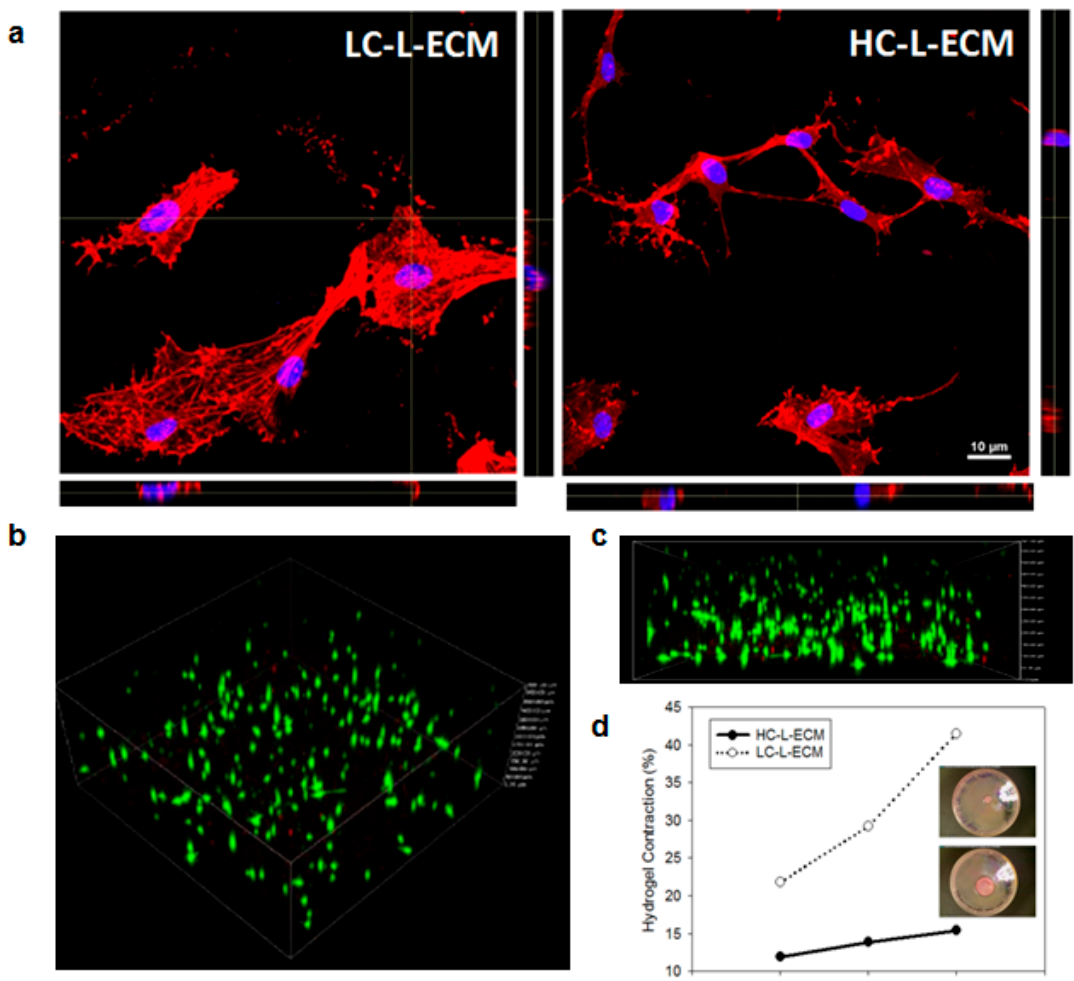
Figure 2. Lung-resident mesenchymal stromal cells (L-MSCs) in 3D lung ECM hydrogels. ( a ) 3D confocal images of the L-MSCs within the hydrogel scaffolds. ( b ) Three-dimensional live/dead image and ( c ) Z-distribution of the bioprinted cells within the 3D hydrogel structure. ( d ) Evolution of contraction of the cell-laden bioprinted low-concentration L-ECM (LC-L-ECM) and high-concentration L-ECM (HC-L-ECM) structures at days 1, 4 and 7.